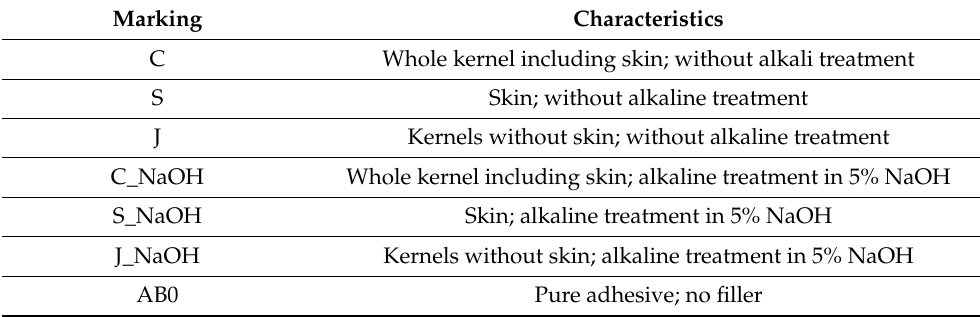
Table 1. Marking and characteristics of fillers (adhesive